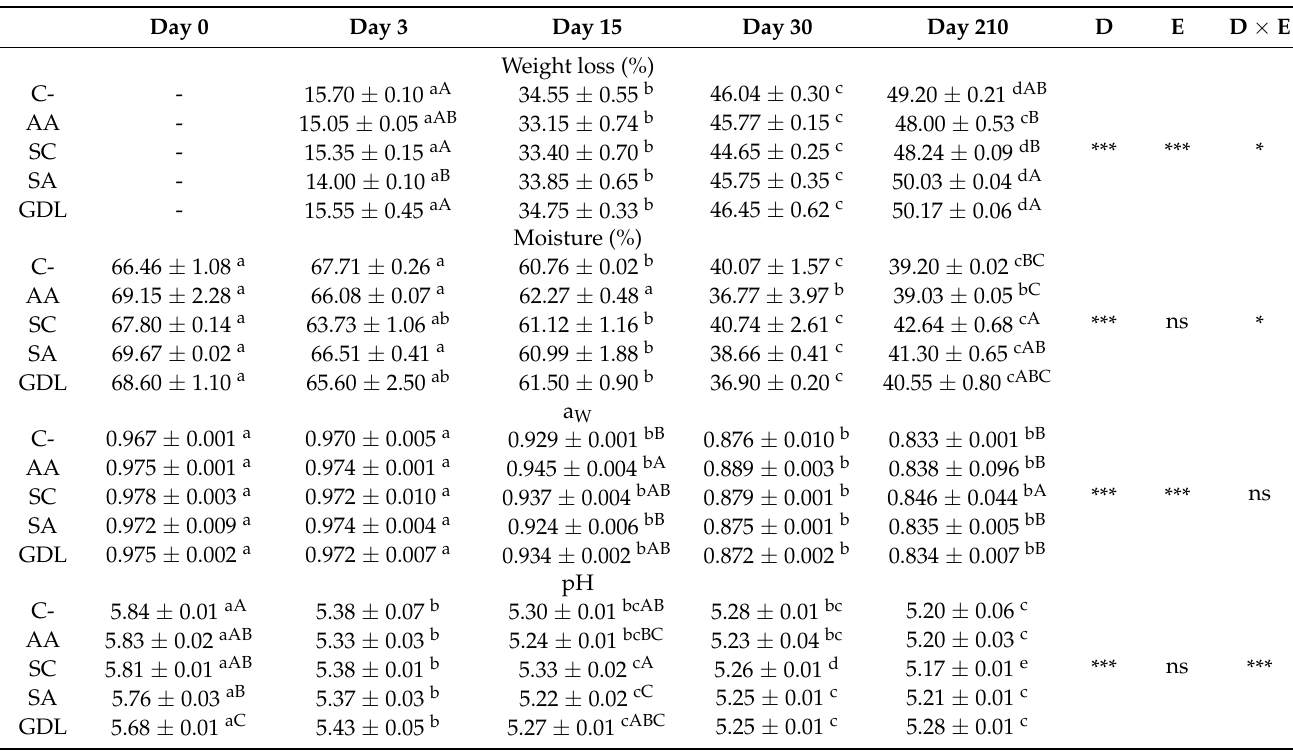
Table 1. Means and standard deviations for weight loss and physico-chemical parameters of sausages manufactured with different reducing agents added during ripening and storage